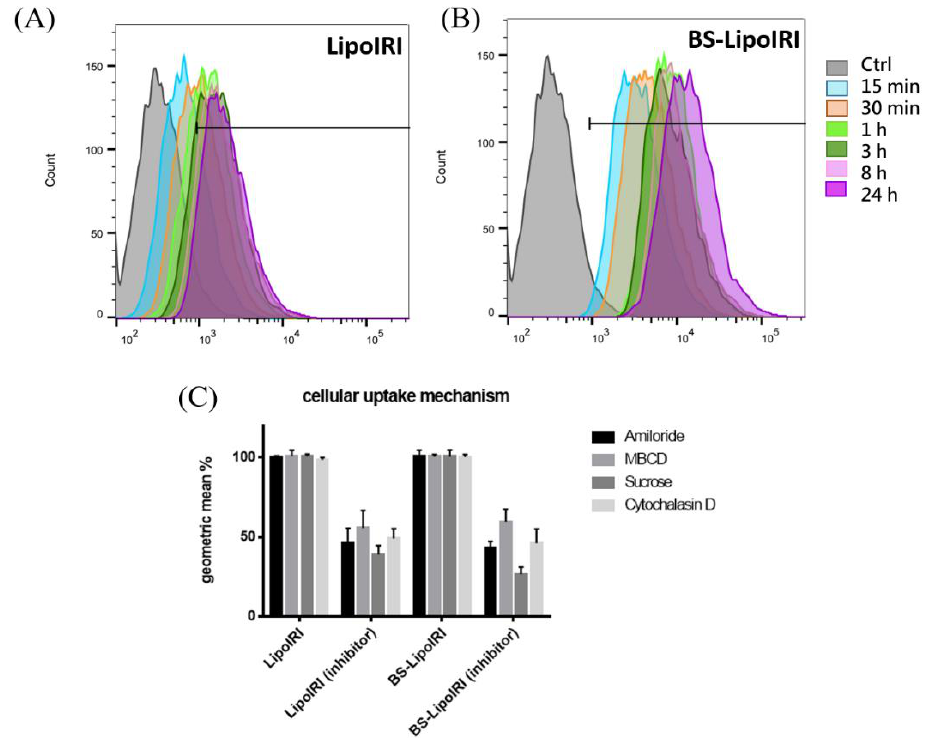
Figure 4. Cellular uptake of the ( A ) DiI-labeled LipoIRI or ( B ) DiI-labeled BS − LipoIRI was examined after incubation of cells at 15 min, 30 min, 1 h, 3 h, 8 h, and 24 h. ( C ) BxPC3 cells were treated with DiI-labeled LipoIRI or BS − LipoIRI for 2 h in the presence of various inhibitors or without inhibitors. The general pathway of nanoparticles internalized into cells is known to be phago- cytosis, micropinocytosis, and caveolae-dependent and clathrin-mediated endocytosis. Herein, we used cytochalasin D as a phagocytosis and macropinocytosis inhibitor [20], amiloride as a macropinocytosis inhibitor [21], MBCD as an inhibitor of lipid rafts in- volved in caveolae-dependent endocytosis [22], and sucrose as a clathrin-mediated endo- cytosis inhibitor [23] to determine which pathway participates in cellular uptake. The re- sults showed that the fluorescence intensities in cytochalasin D, amiloride, MBCD, and sucrose were significantly reduced, and the BS−Lipo IRI group has a similar uptake level compared to LipoIRI. It indicated that the modified antibody does not change the uptake mechanism of nanoparticles. The upregulated cellular uptake efficiency was promoted by anti-EGFR specific targeting. 3.5. In Vitro Bxpc3 Cell Viability BxPC3/EGFR pancreatic tumor cells were cultured with LipoIRI or BS−Lipo IRI for 3 h to evaluate the cell viability by MTT assay. The results showed that a dose-dependent effect was observed with BS−Lipo IRI on BxPC3 cells (Figure 5). The reason is probably that the anti-EGFR antibody promoted the transport of BS−Lipo IRI into the cell, causing a significant difference in cell cytotoxicity.